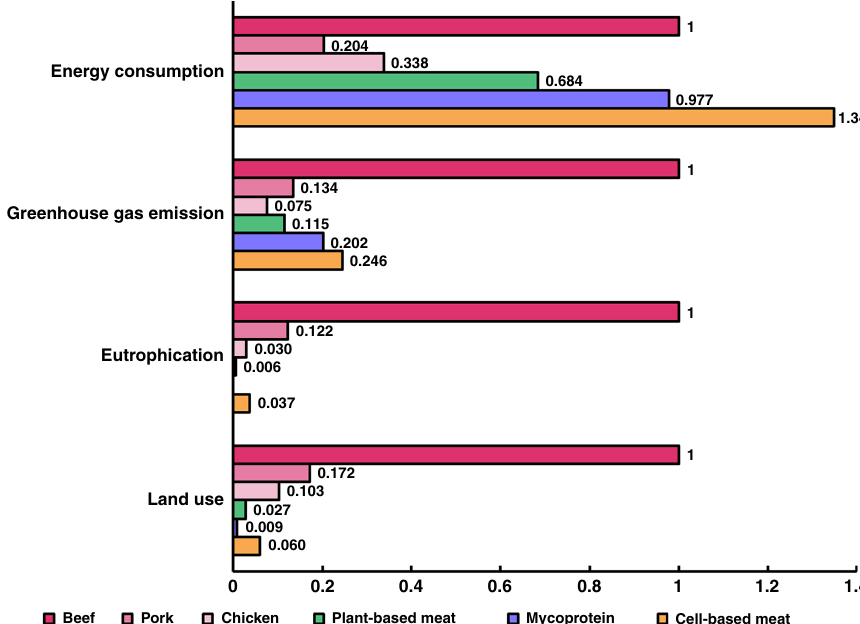
Fig. 5 Comparison of the environmental impact of meat and meat analogs. Data are normalized to the impact of beef production. Eutrophication does not include data for mycoprotein. Land, emissions and energy data for mycoprotein were adapted from a 2015 LCA 72 . Data for beef, pork, chicken and CBM were adapted from a 2015 life cycle assessment 75 . Data for PBM were adapted from an Impossible ™ Beef LCA (land, eutrophication, emissions) and a Beyond Meat ® life cycle assessment (energy use) 70,71